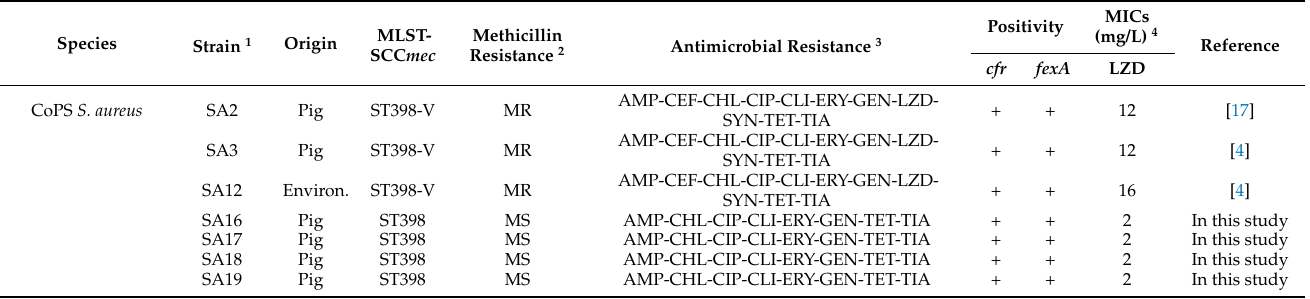
Table 1. Genetic characteristics and antimicrobial resistant profiles of cfr -positive staphylococci isolated from pig